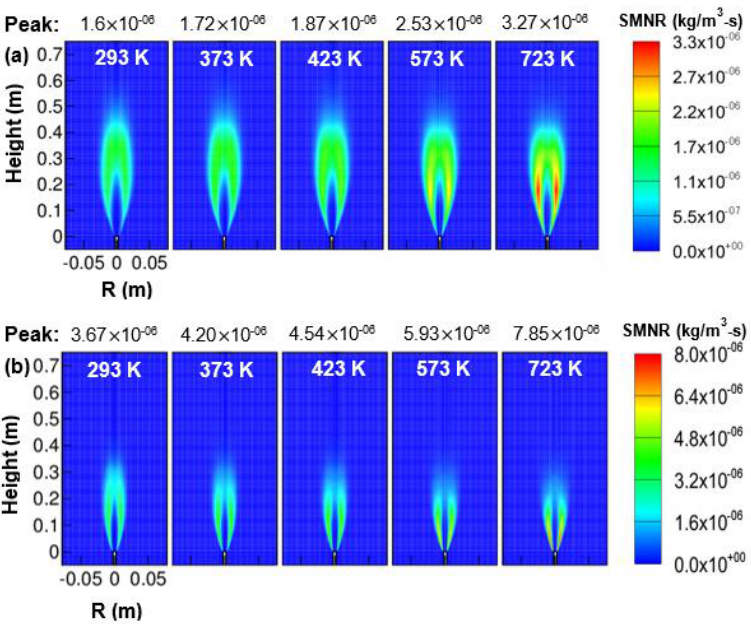
Figure 14. Soot-mass nucleation-rate (SMNR) contour as a function of air temperature; ( a ) 1 atm, and ( b ) 3 atm.